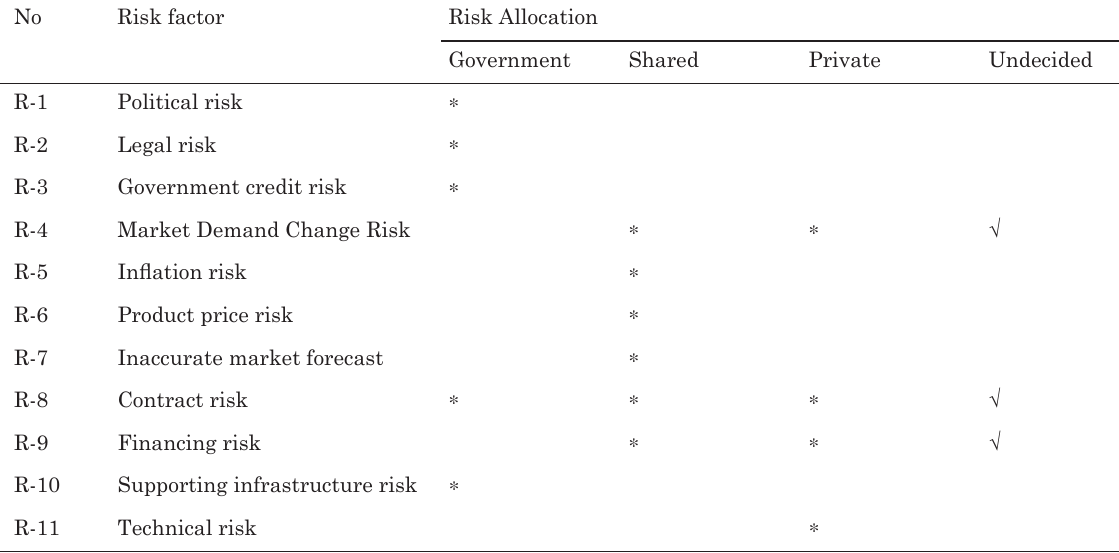
table 4. risk allocation matrix of critical